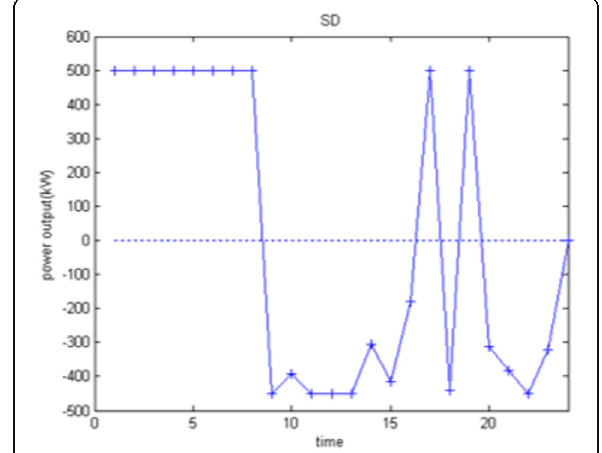
Fig. 12 The profile of load shifting cost